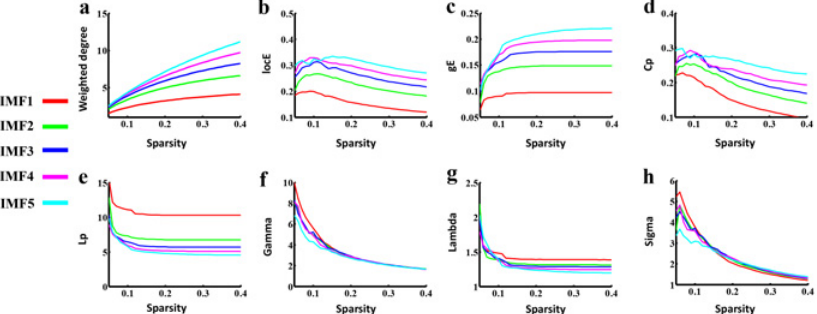
Fig 3. Small world properties in the frequency specific FCNs. From Fig 3a to Fig 3e, each figure shows the plot of global topological patterns of distinct frequency intervals (y-axis) versus sparsity (x-axis), including the weighted degree, local network efficiency (locE), global network efficiency (gE), mean clustering coefficient (Cp) and shortest path length (Lp) respectively. The ratio Gamma (Fig 3f) and Lambda (Fig 3g) of five frequency specific FCNs showed a much higher Cp and identical Lp value, compared with closely matched random networks across much sparsity. The saliency of small-worldness, Sigma, dynamically covered different frequency bands at various density intervals. Specifically, small world architecture is prominent in the IMF1, IMF3 and IMF5 component at a range of density threshold from 0.05 to 0.12, 0.12 to 0.18, and 0.24 to 0.4,